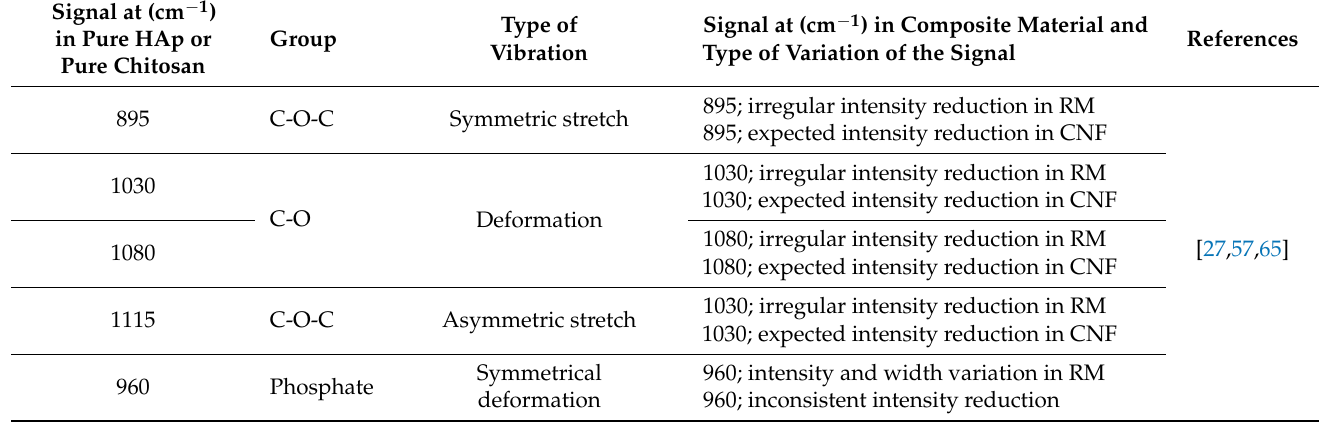
Table 2. Positions of and variations in Raman signals from all types of